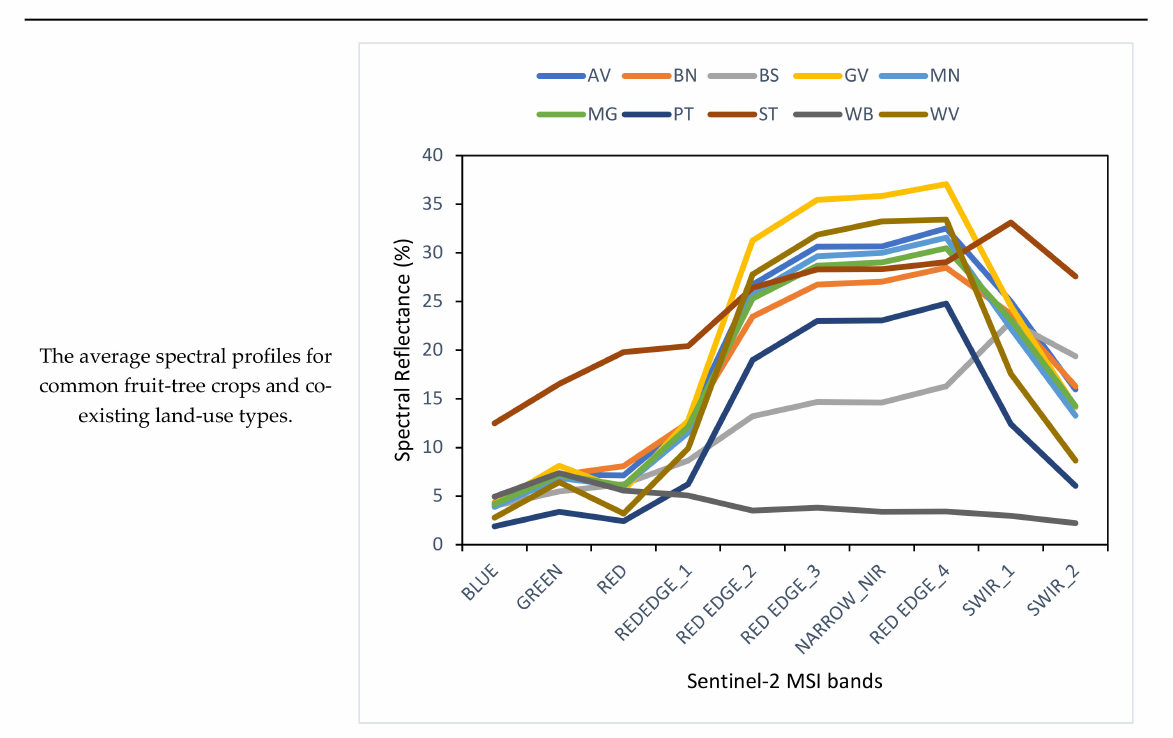
Figure 3. Average spectral reflectance profiles extracted from Sentinel-2 data on fruit-tree crops and co-existing land-use types, reference data, and field photos. The mapped classes are avocado (AV), banana (BN), bare soil (BS), guava (GV), macadamia nut (MN), mango (MG), pine tree (PT), built-up (BU), water body (WB), and woody vegetation